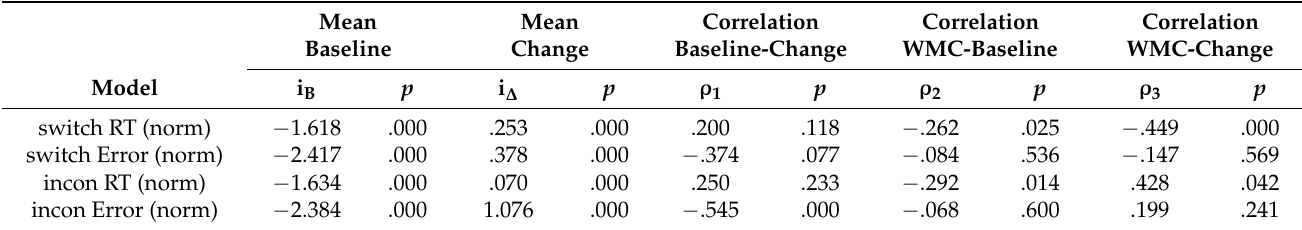
Table A3. Parameter estimates of LDS models for observed performance scores.